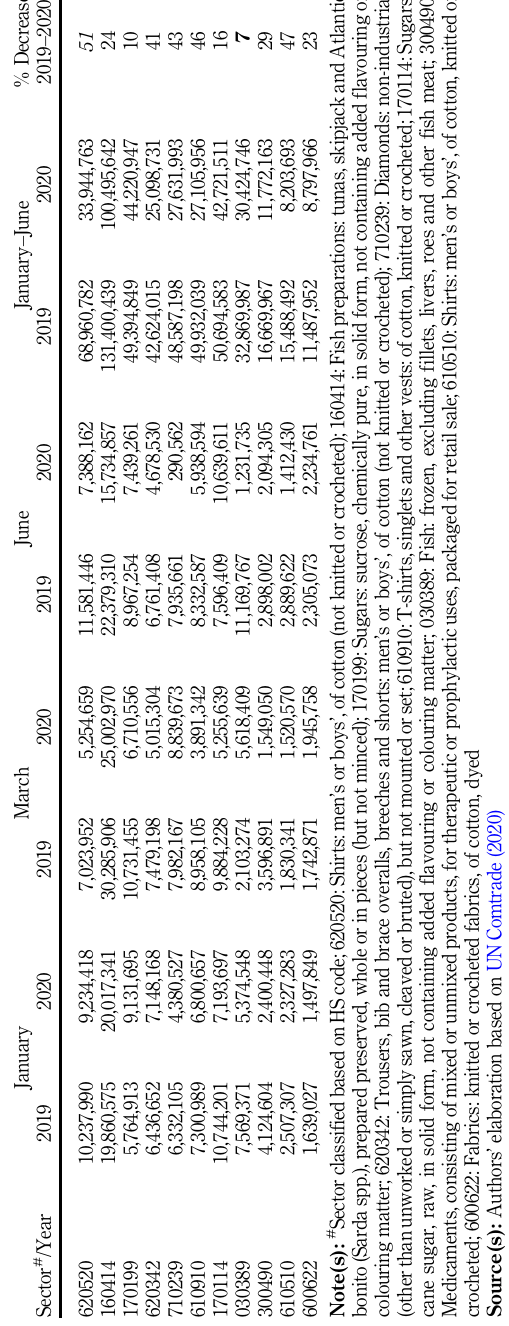
Table 2. Export trade value (US$) of main export sectors for the